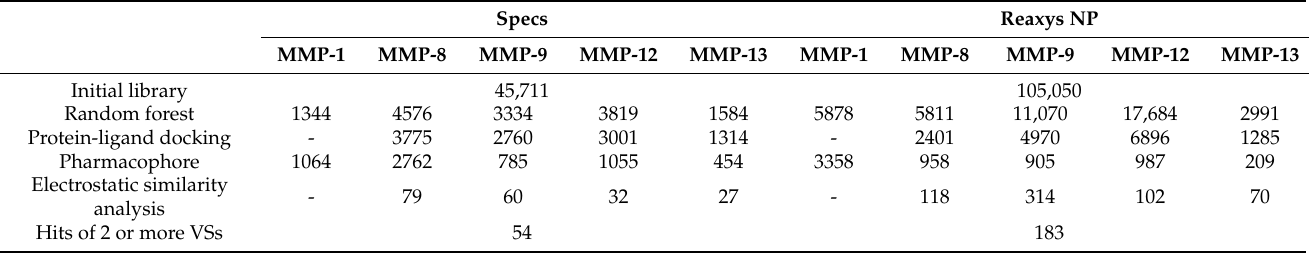
Table 1. VS workflow filters and number of compounds that surpassed each VS filter for each